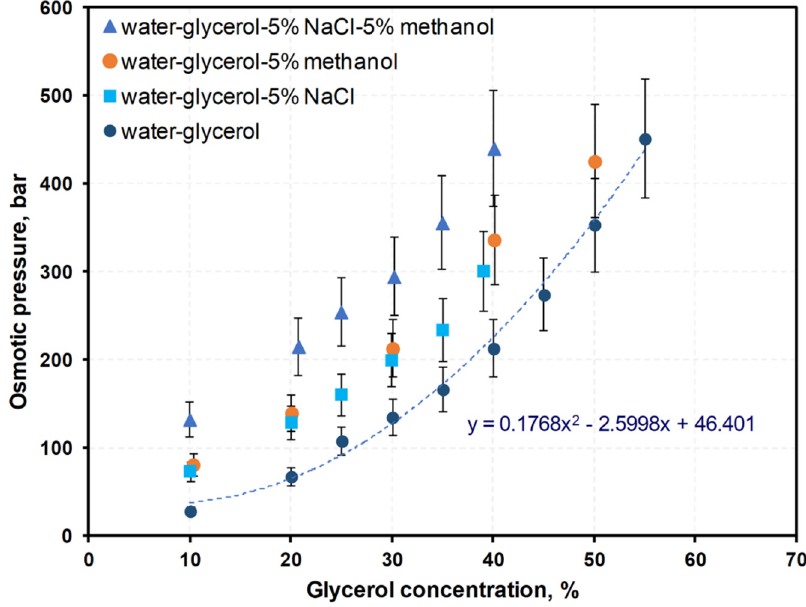
Figure 2. The effect of salt and methanol on osmotic pressure, calculated based on freezing point depression measurements in water–glycerol–NaCl–methanol systems.